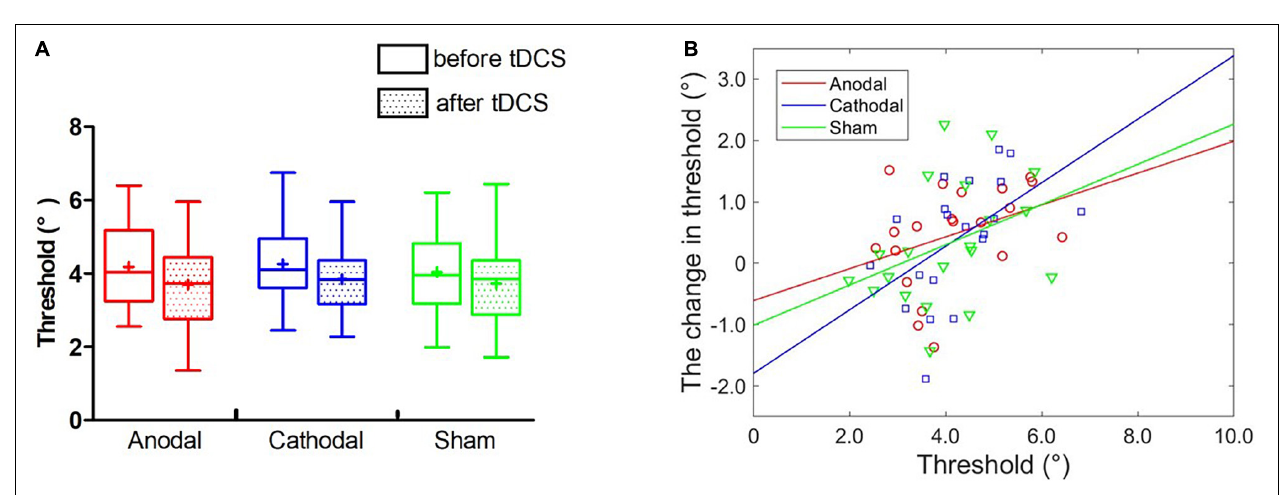
FIGURE 5 | Effect of tDCS over the left STS on the threshold of face view discrimination. (A) The average thresholds are depicted before and immediately after tDCS. Error bars indicate standard errors (SE). (B) The baseline threshold as a function of the magnitude of threshold change for each type of stimulation.